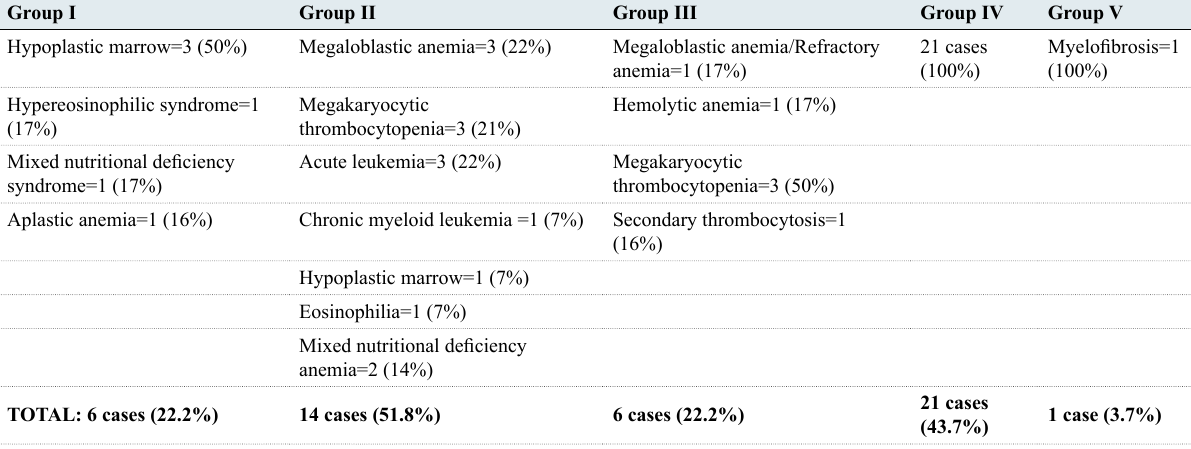
Table 3: Categorization of Bone marrow findings (n=48). Group